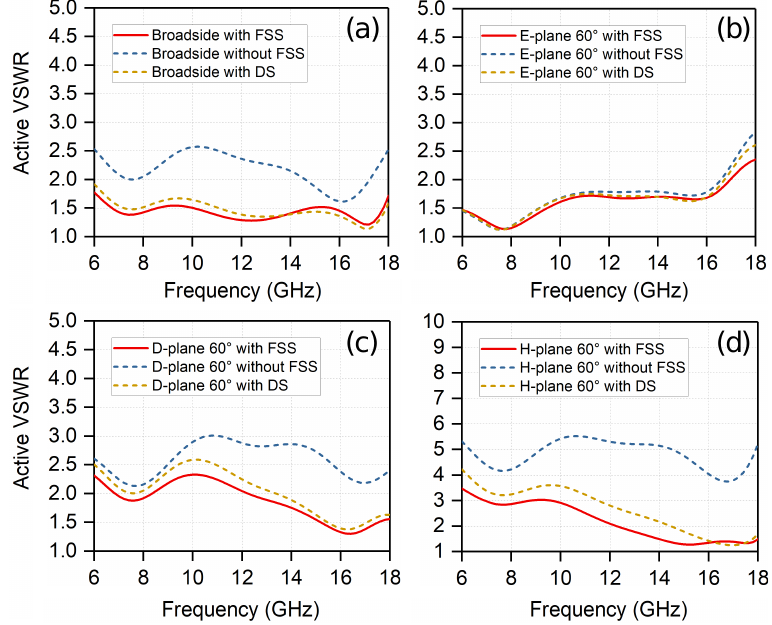
Figure 7. Comparisons of active VSWR when scanning to ( a ) broadside; ( b ) 60 ◦ in the E-plane; ( c ) 60 ◦ in the D-plane; and ( d ) 60 ◦ in the